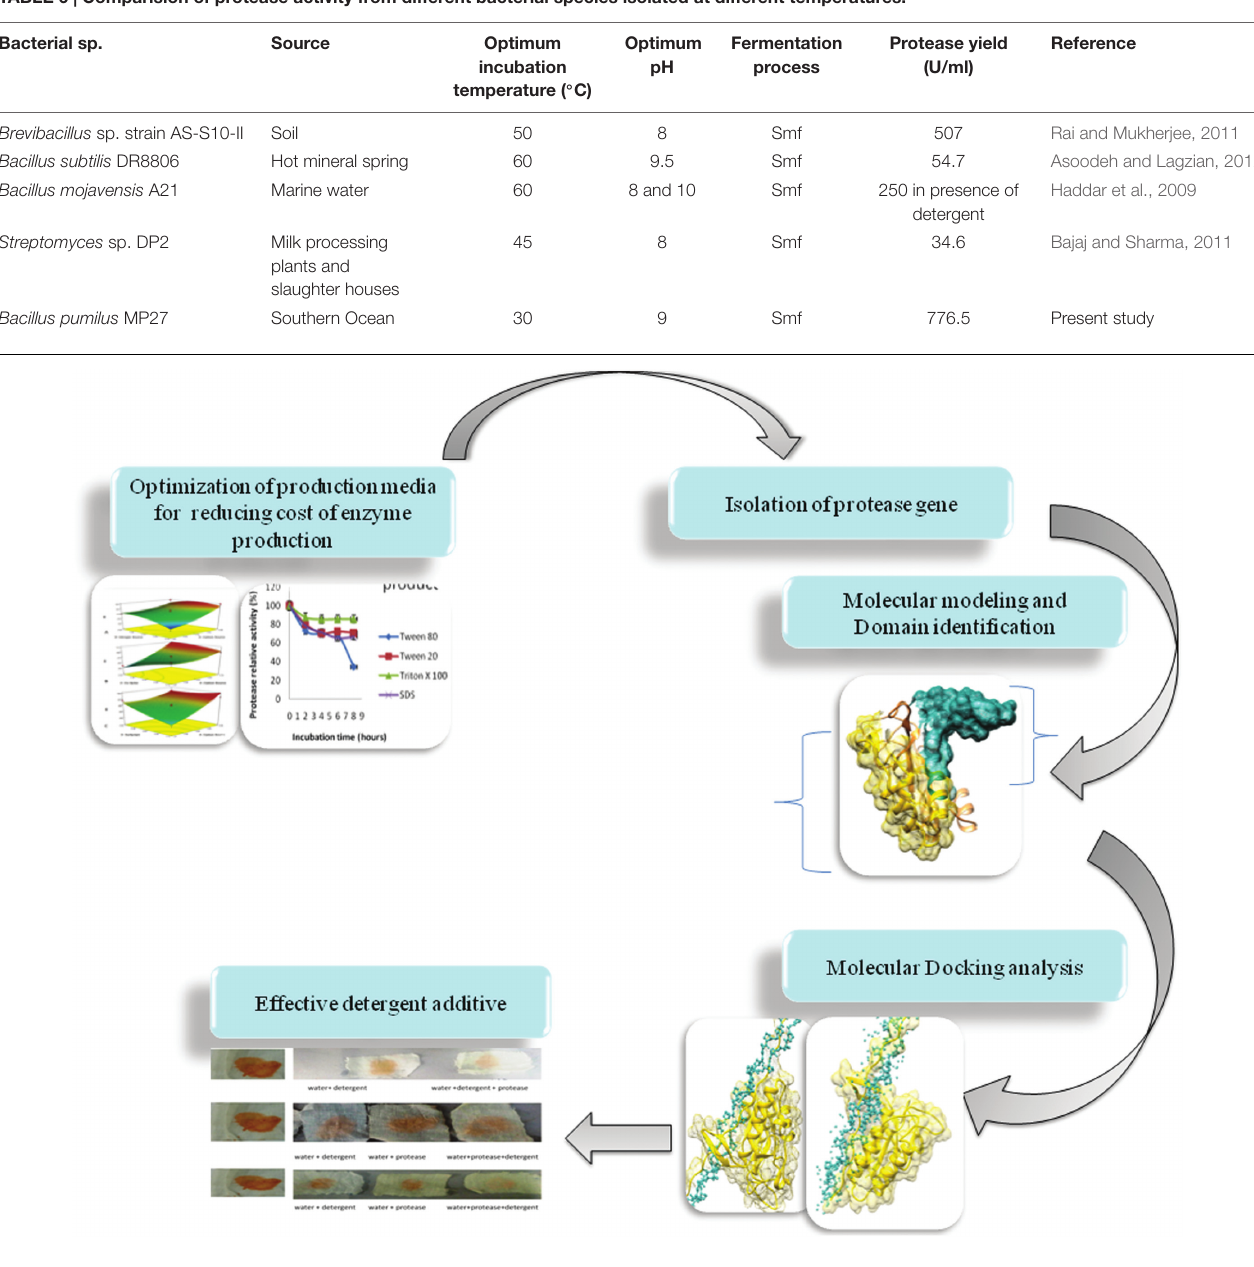
FIGURE 8 | Highlighted outcome of current work: a